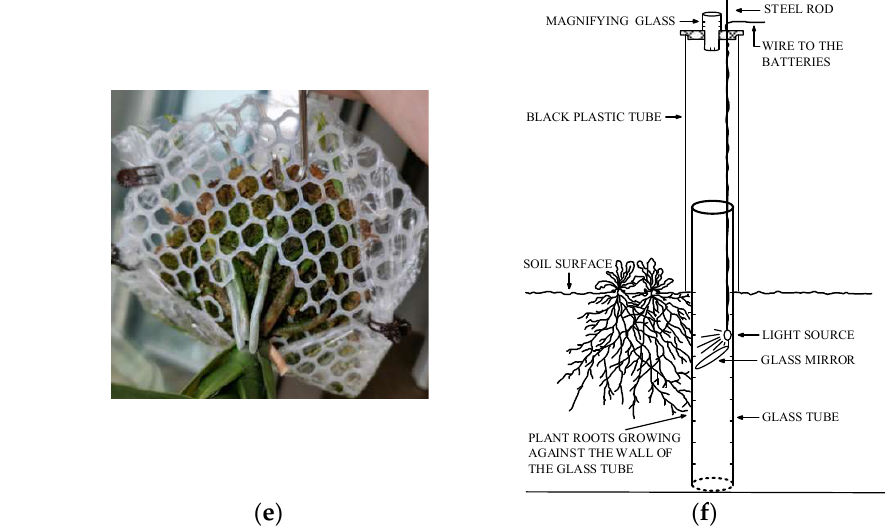
Figure 2. Non- destructive methods: ( a ) Internal growth Method; ( b ) Container Method; ( c ) Isotope Probing Method; ( d ) Soilless Cultivation Method; ( e ) Mesh bag Method; ( f ) Minirhizotron Method. [5,6].